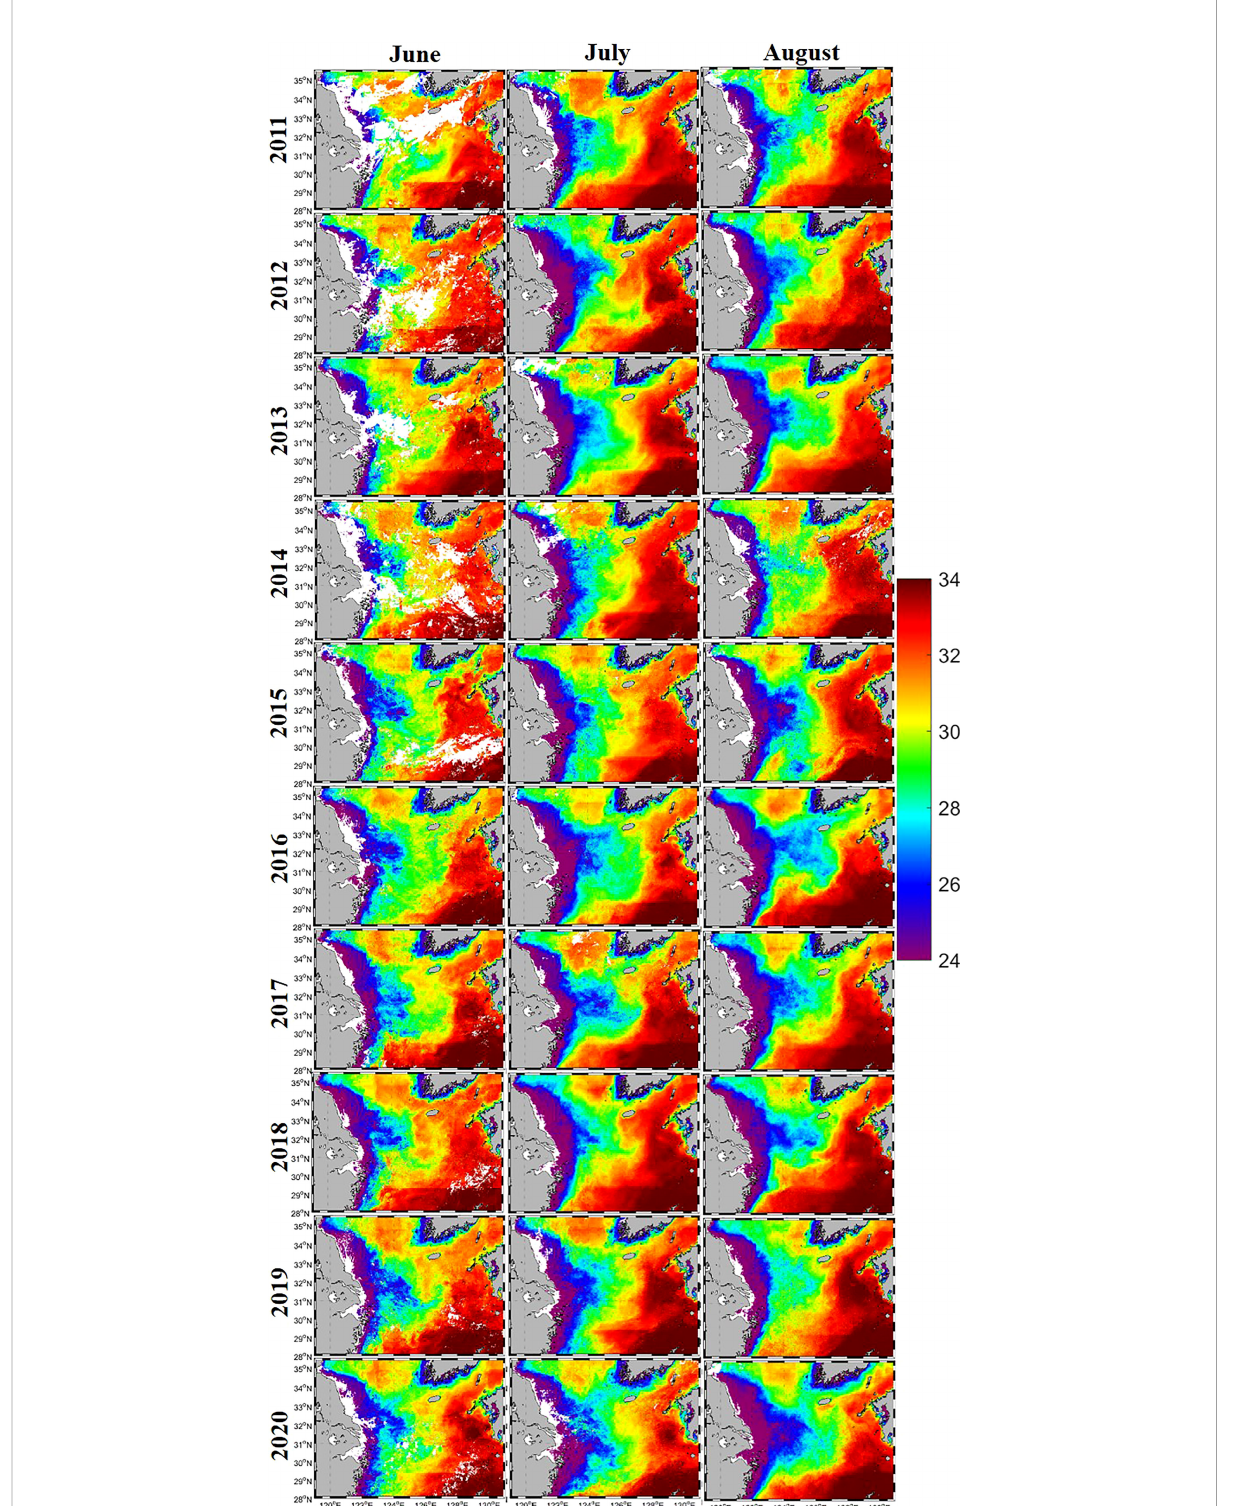
FIGURE 9 Salinity (psu) calculated from monthly GOCI images using Eq. 4 during summer in the period 2011 –